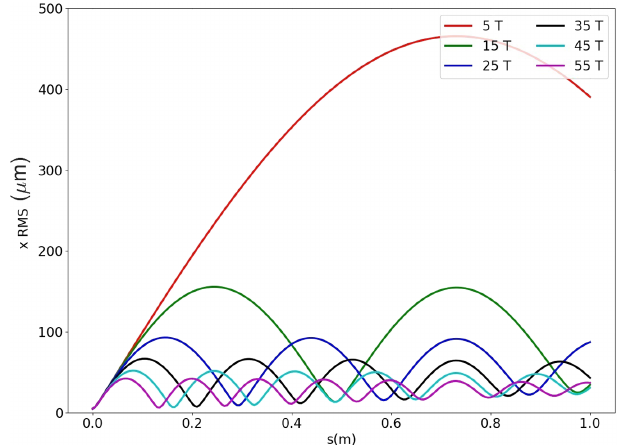
FIG. 12. Transverse beam size over distance with a solenoid for different magnetic field strength B.